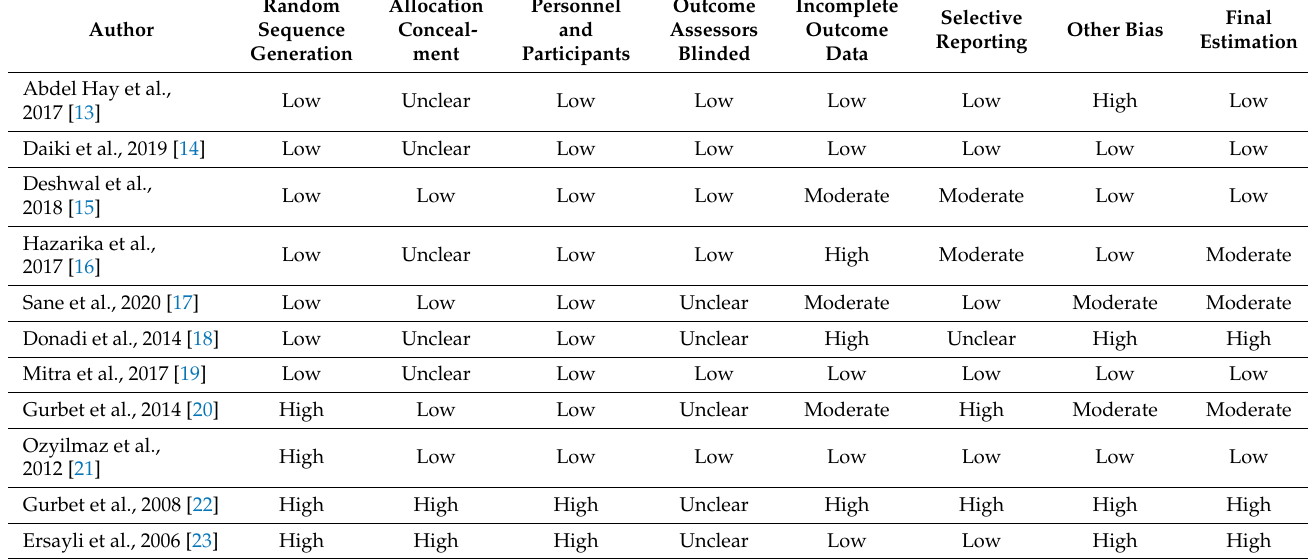
Table 2. Critical appraisal of bias of the included trials assessing local wound infiltration for pain control after lumbar spine surgery using Cochrane Collaboration of Risk